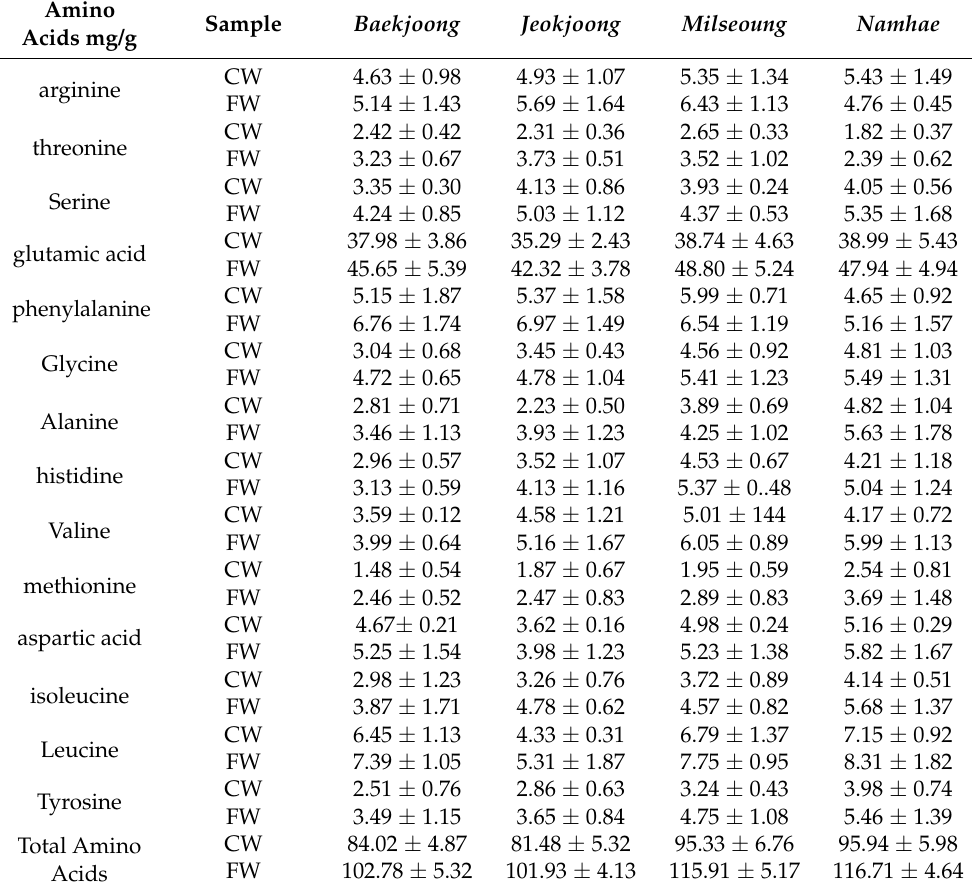
Table 1. The composition of free amino acids in cooked and fermented wheat. Amino Acids mg/g